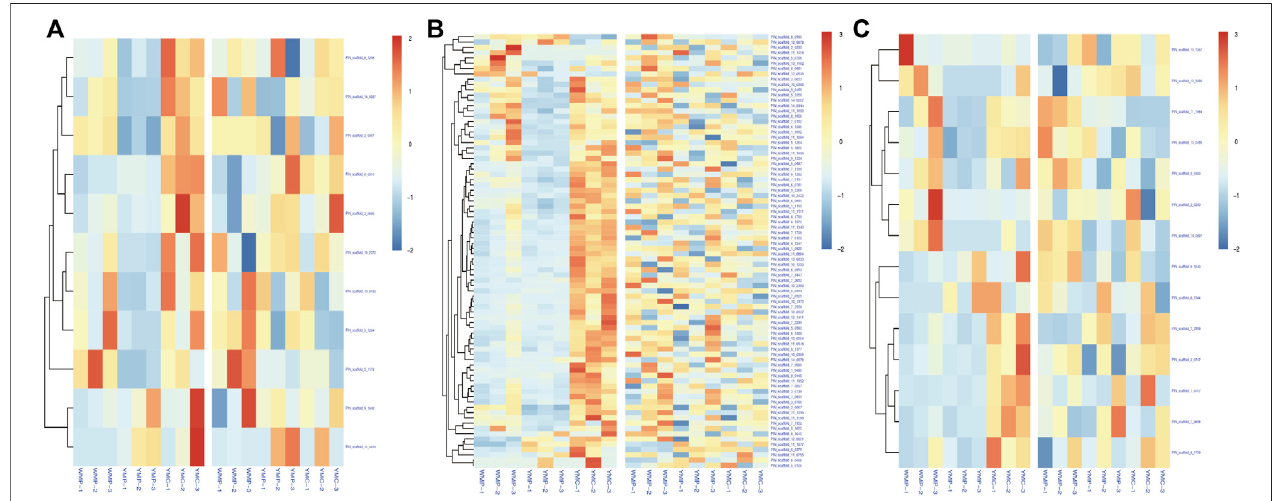
FIGURE 6 | Correlation of DMR-related genes and DEGs. (A) Up-stream 2k; (B) genebody; (C) down-stream 2k.